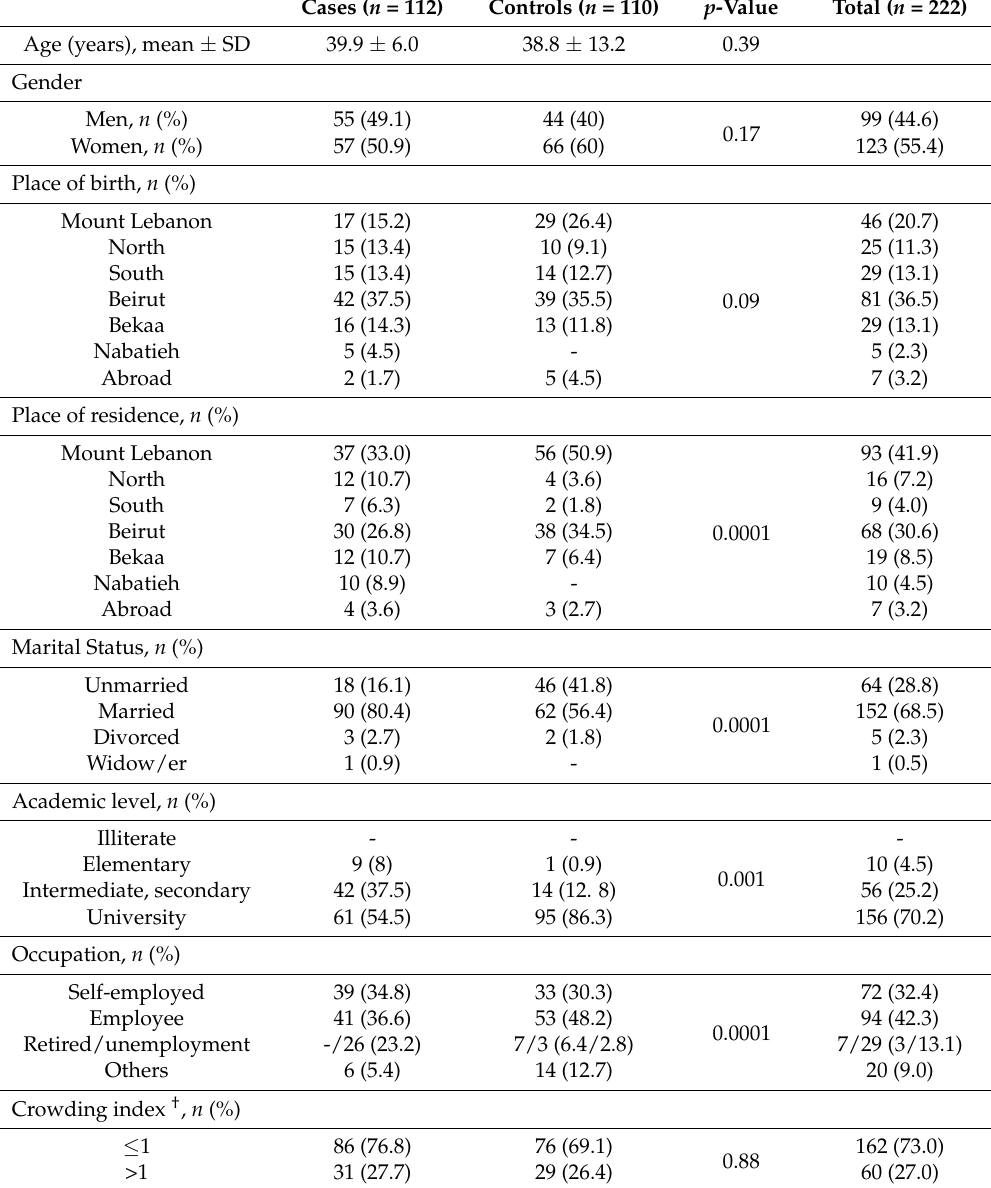
Table 1. Comparison of age and sociodemographic data between cases and